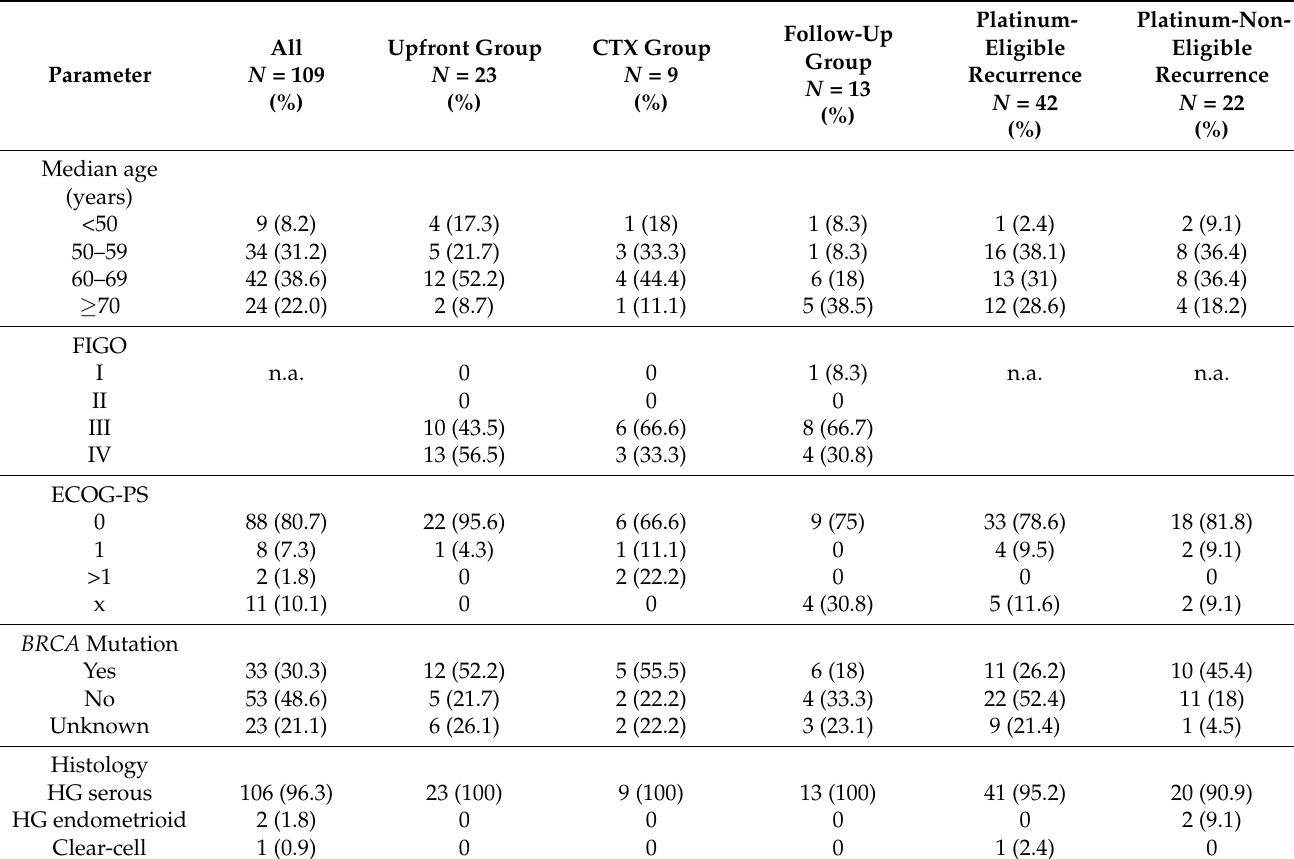
FIGO: F é d é ration Internationale de Gyn é cologie et d’ Obst é trique; HG: high-grade; ECOG-PS: Eastern Cooperative Oncology Group-performance score. ROC curve analysis of the healthy controls versus the upfront group yielded an optimal cut-off (Youden index) of 24.5 with a corresponding specificity/sensitivity of 95% and 91%, respectively. The 99.6% percentile of the control group, which was suggested as the ideal fixed specificity for ovarian cancer screening by others before [17] corresponded to a CNI-Score of 33 (Table